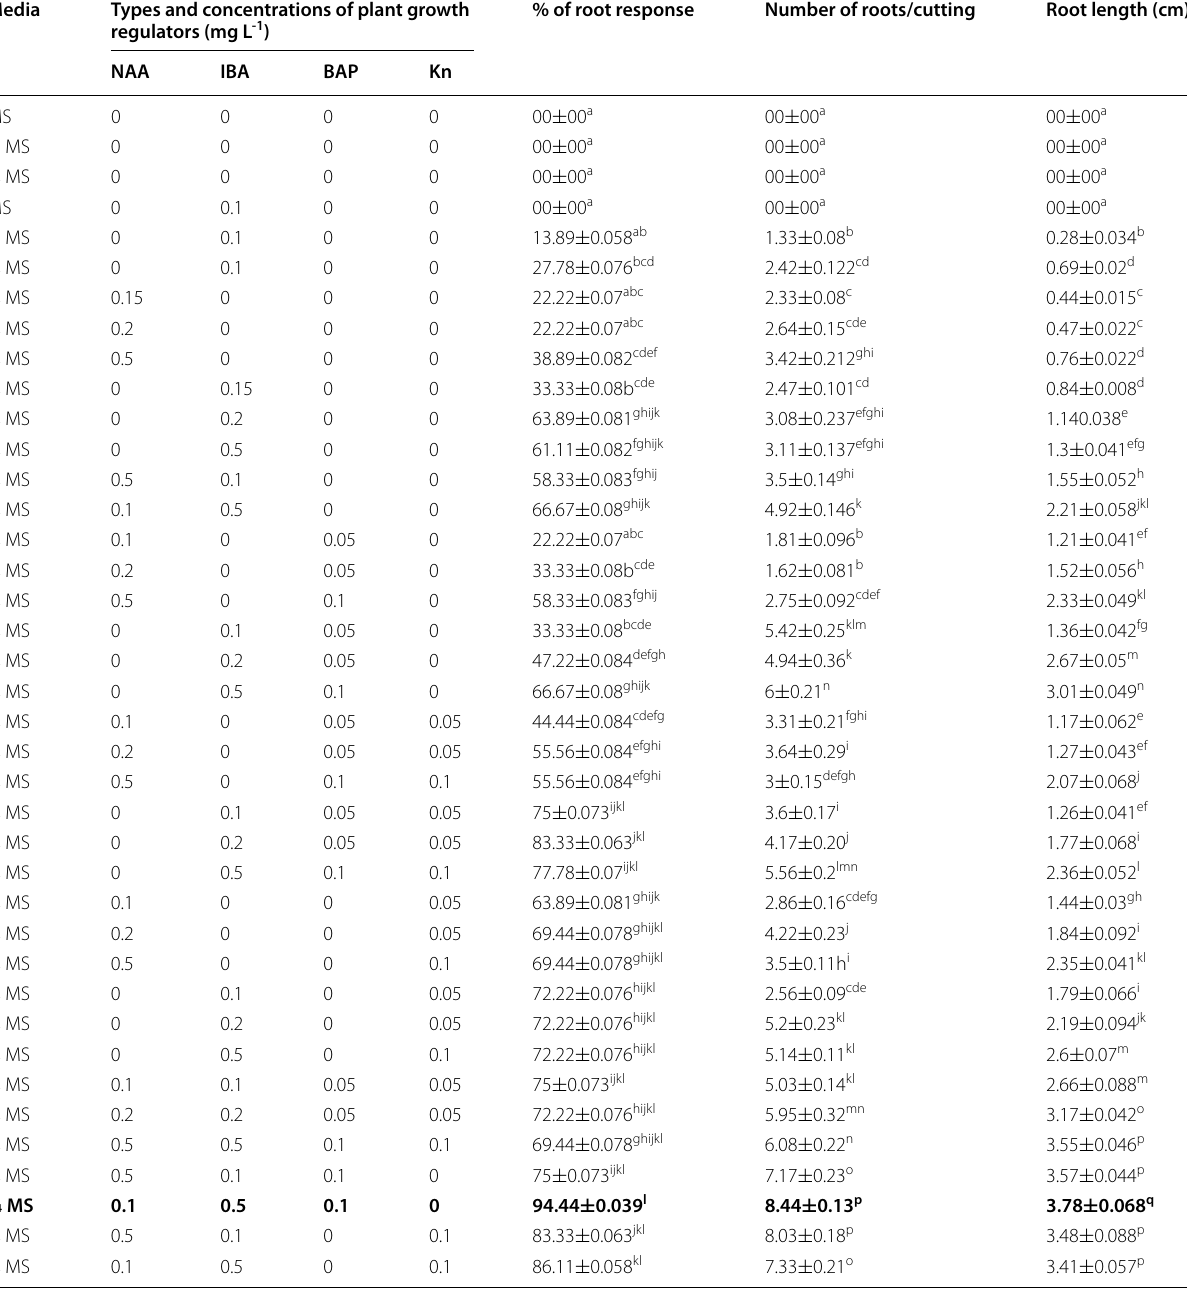
Table 4 The effects of various auxins and cytokinins on the initiation and growth of in vitro roots on different strengths of Murashige and Skoog medium of induced micro shoots of Artocarpus heterophyllus